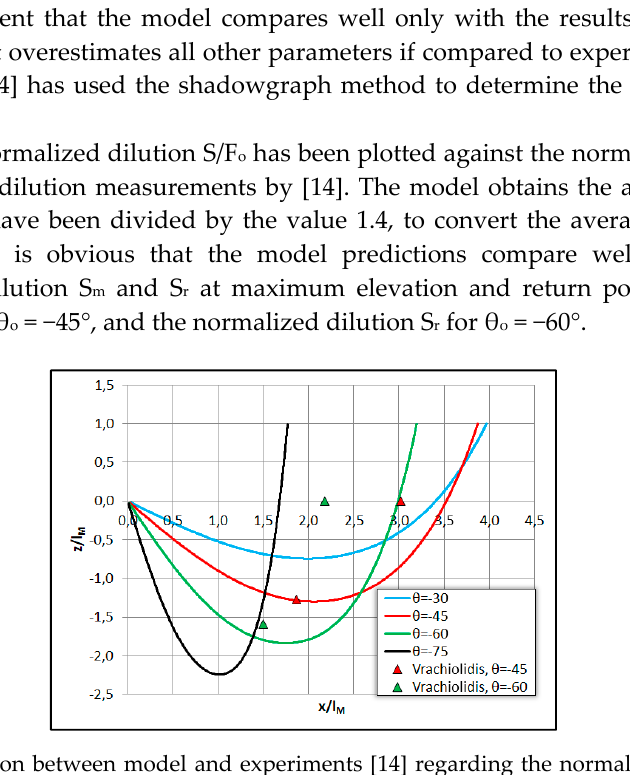
Figure 7. Comparison between model and experiments [14] regarding the normalized trajectory of negatively buoyant heated jets.